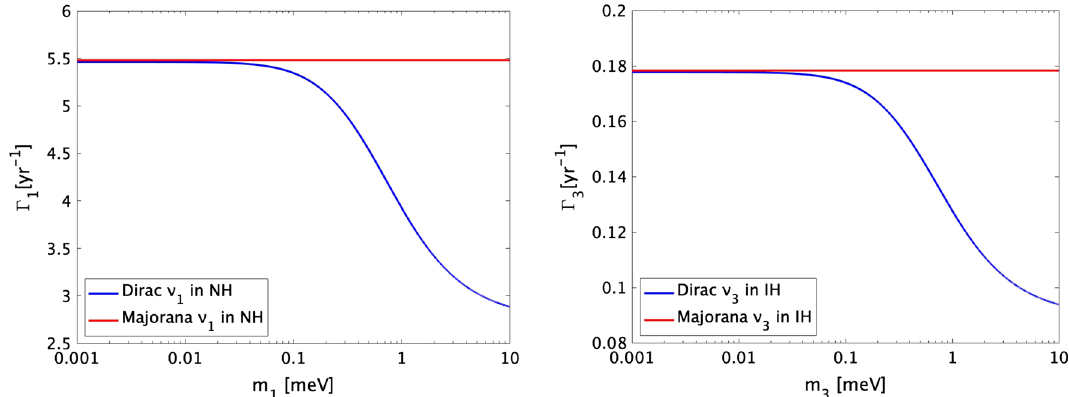
Fig. 1 The capture rate for the lightest neutrinos on a 100 g tritium experiment in the NH (left panel) and IH (right panel) cases as a func- tionofthelightestmass.Weincludetheneutrinospectraldistortionfrom